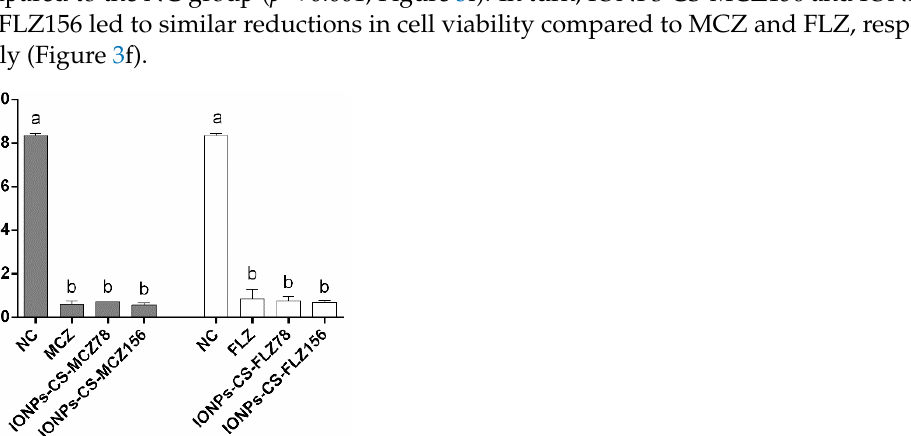
Figure 2. Mean values (standard deviation) of lactic acid concentration from microcosm biofilms formed for 96 h and treated with different compounds. Biofilms were treated during 24 h with miconazole at 156 µg/mL (MCZ), chitosan (CS)-coated iron oxide nanoparticles (IONPs) carrying MCZ at 78 (IONPs-CS-MCZ78) and 156 µg/mL (IONPs-CS- MCZ156), fluconazole at 156 µg/mL (FLZ), and FLZ-containing nanocarrier at 78 (IONPs-CS-FLZ78) and 156 µg/mL (IONPs-CS- FLZ156). The negative control (NC) represents the biofilm formed for 120 h with pure culture me- dium. Error bars depict standard deviations of the means. Different lowercase letters represent sig- nificant differences among the groups (one-way ANOVA and Fisher LSD’s test; p < 0.05). Compar- isons were performed separately for each antifungal, its respective nanocarrier, and the NC.